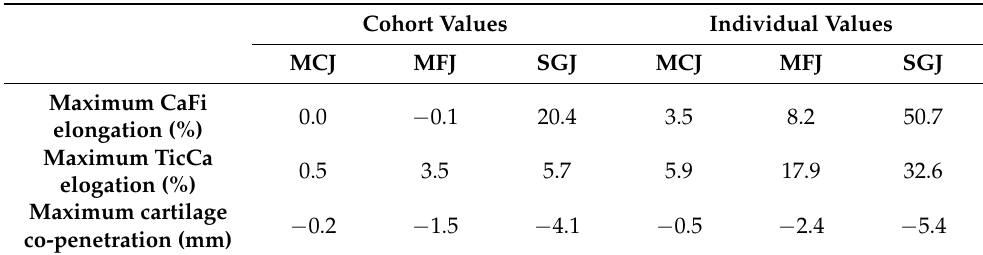
Figure 3. FiCa ( A ) and TiCa ( B ) and minimum cartilage-to-cartilage distance ( C ) values for the average cohort, plotted versus ankle flexion angle for the three ankle models. Bottom gray bars represent the flexion angle values for which post hoc tests were significant. Table 1. Maximum ligaments elongations and cartilage co-penetration over the entire Range of Motion (ROM) for the average cohort and individuals.